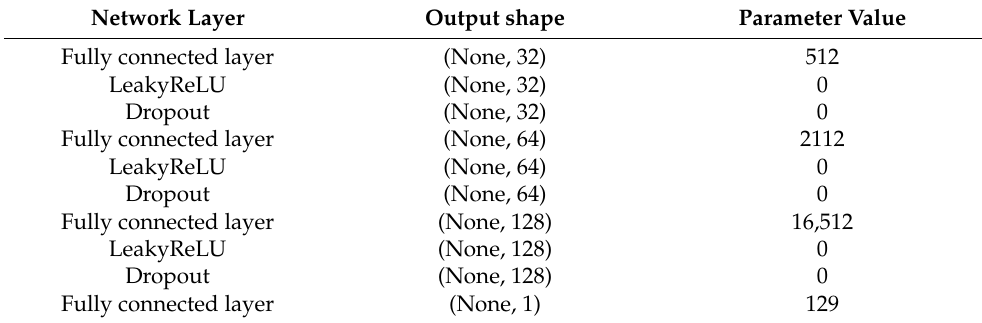
Table 2. Discriminator network parameters.